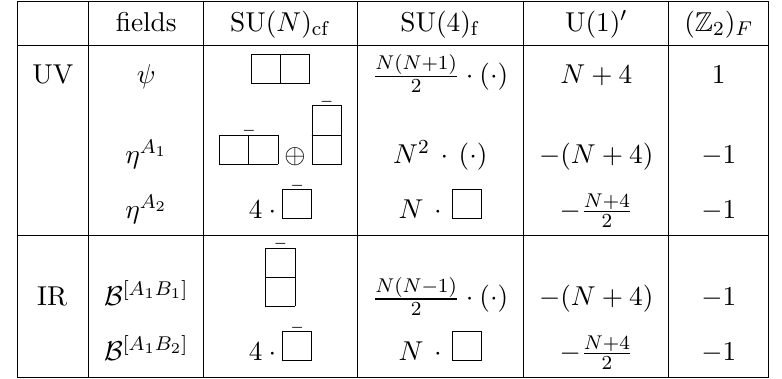
Table 2 . Color-(cid:13)avor locked phase in